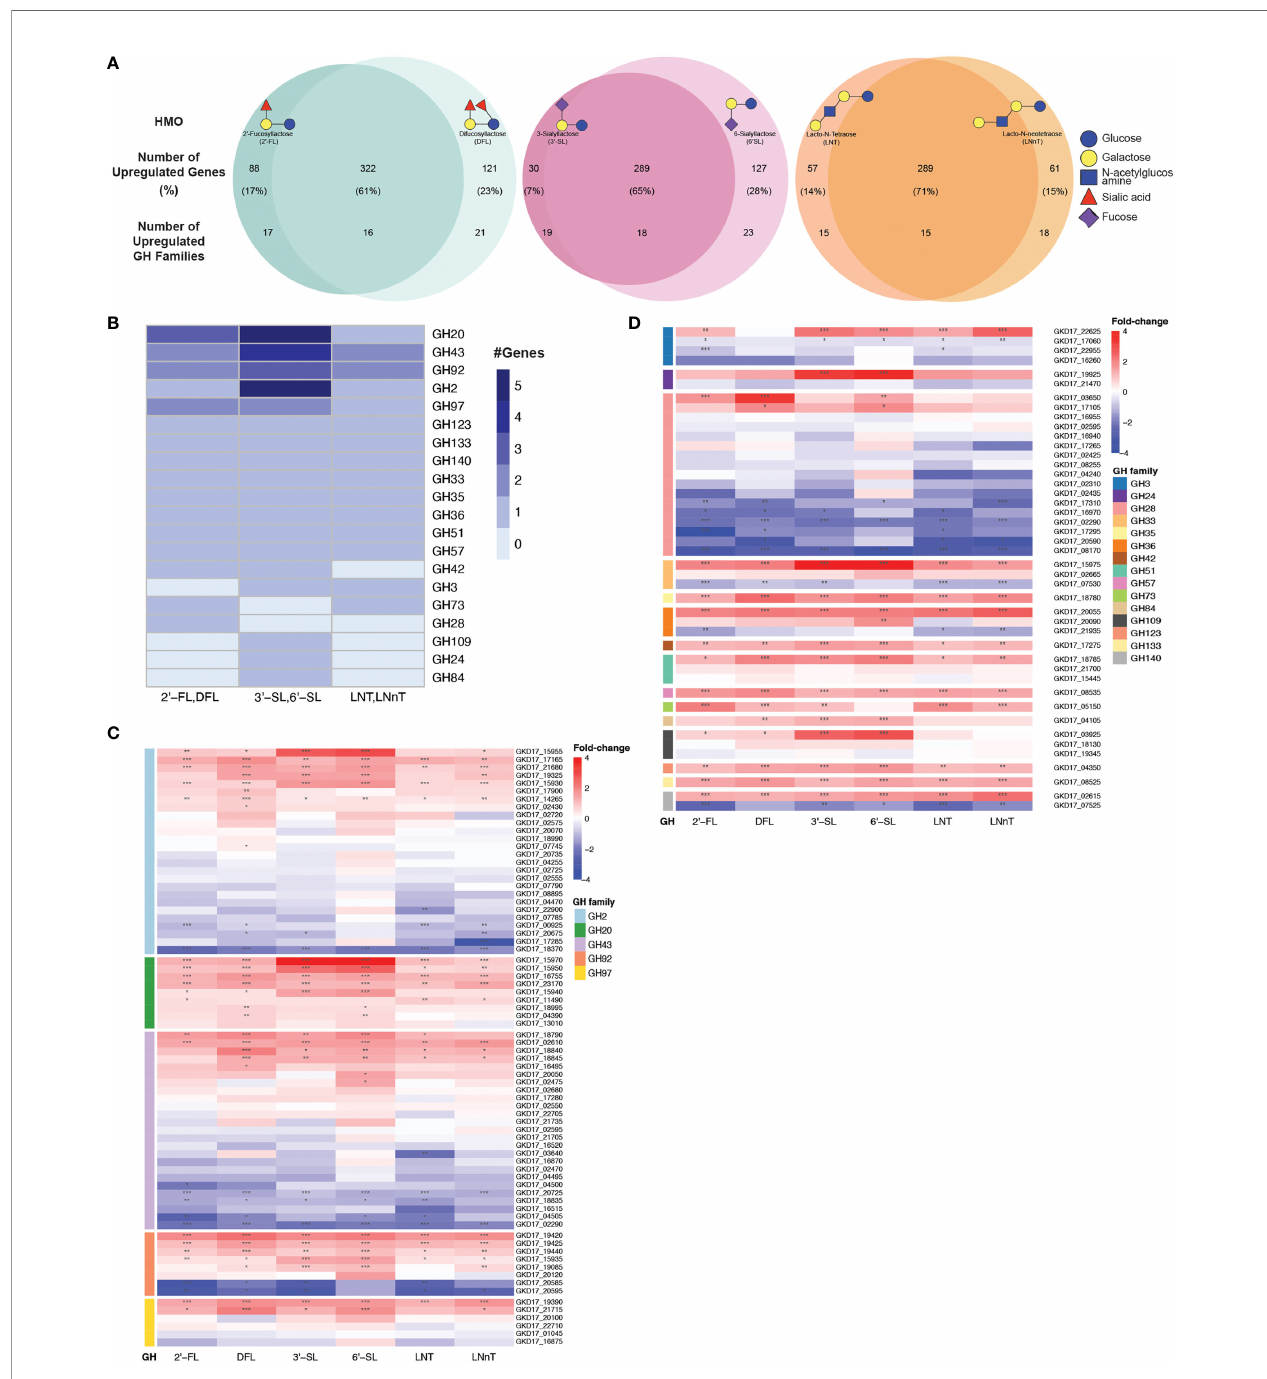
FIGURE 4 | B. dorei shares up-regulated genes upon growth on HMOs compared to glucose. (A) Venn diagrams of B. dorei ’ s up-regulated genes and glycoside hydrolase (GH) families across HMO types, highlighting the similar transcriptional response to HMOs, regardless of speci fi c conditions. HMOs were divided into pairs based on structural similarity. Percentage values refer to the fraction of up-regulated genes from the total up-regulated genes in both members of an HMO pair. (B) A heat map showing the number of up-regulated genes in each up-regulated GH family in at least one HMO pair. (C, D) Heat maps of log2 fold-change of genes (rows) belonging to GH families with (C) at least two; or (D) a single up-regulated gene(s). Gene expression data on HMOs (2 ’ -FL, DFL, 3 ’ -SL, 6 ’ -SL, LNT, LNnT; columns) was compared to gene expression on glucose. p < 0.05 (*); p < 0.01 (**); p < 0.001